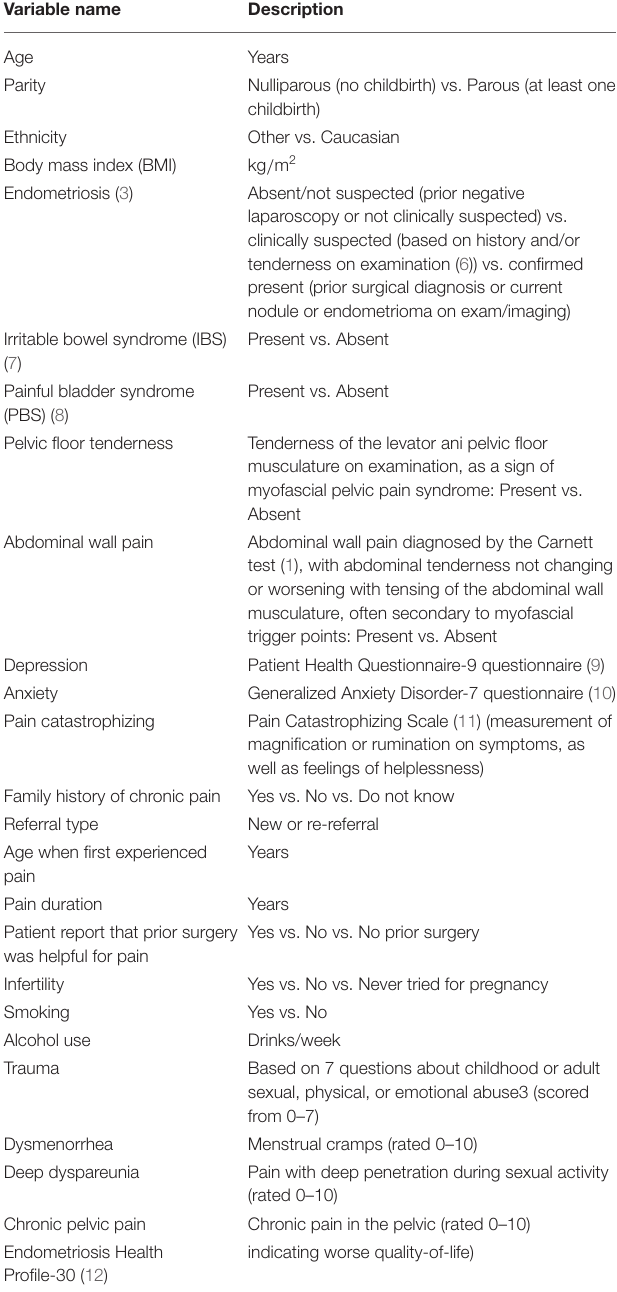
TABLE 1 | The 25 factors of clinical importance to chronic pelvic pain used in this